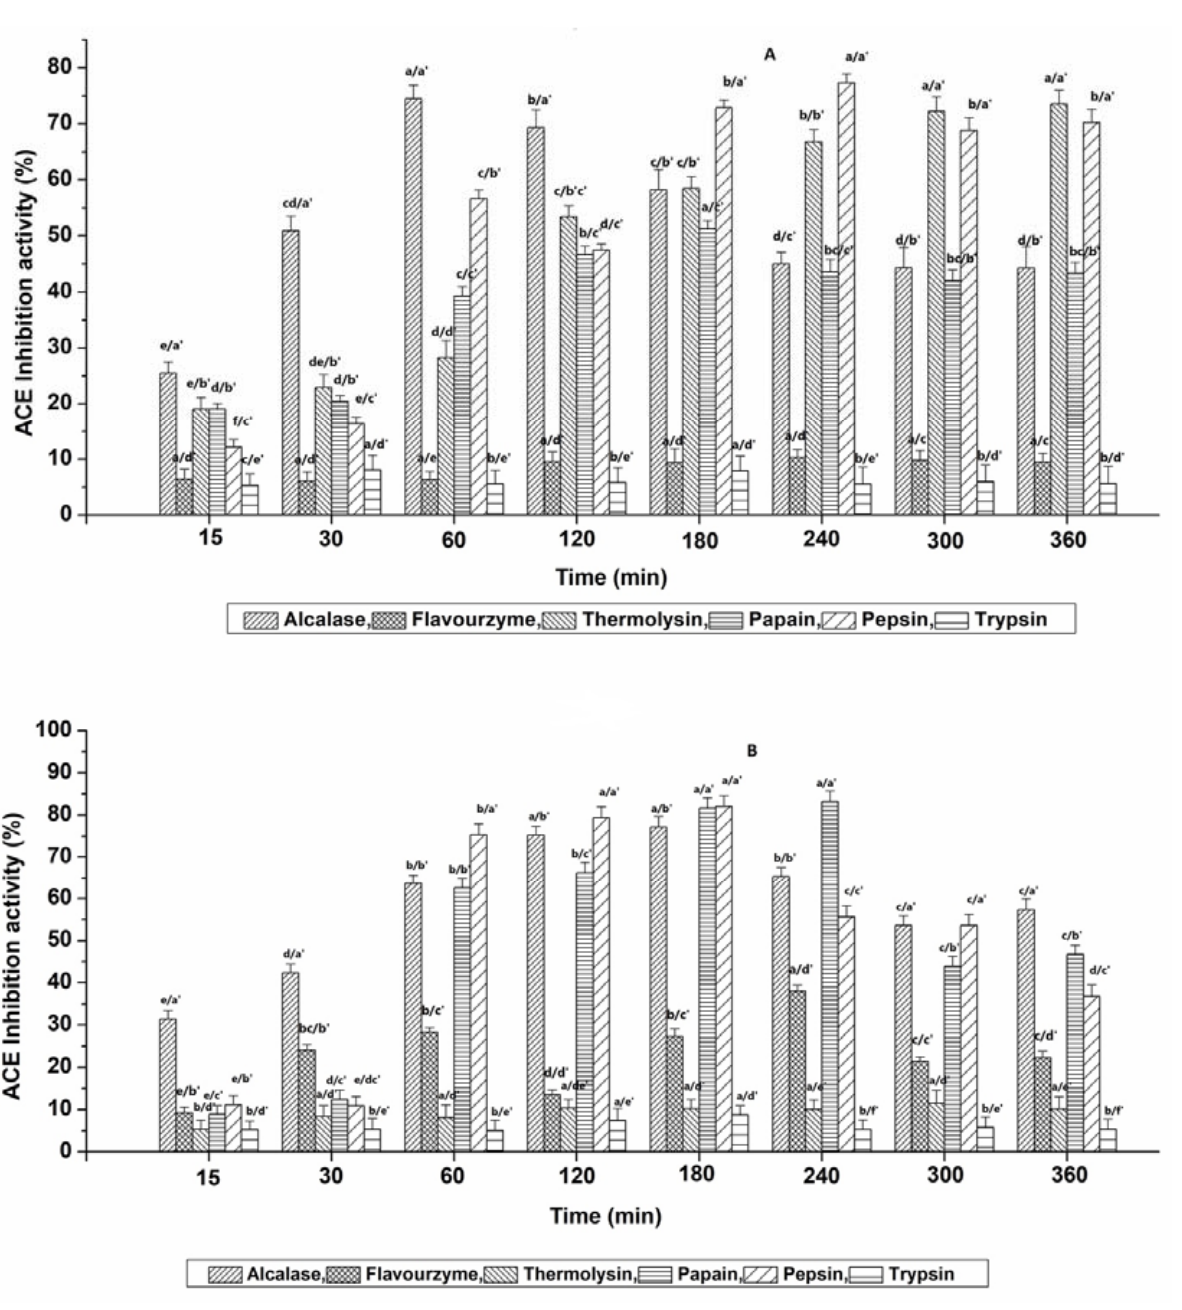
Figure 2. Influence of six proteases on the ACE-inhibition activity of hydrolysates obtained from ( A ) Muga pupae protein extract (MPPC) and ( B ) Eri pupae protein extract (EPPC). The values are expressed as mean ± SD of triplicate tests. Statistical difference ( p < 0.05) within the same enzyme at different time points is denoted by letters a–e, and difference within six various enzymes at each time point is denoted with letters a ′ –e ′ .